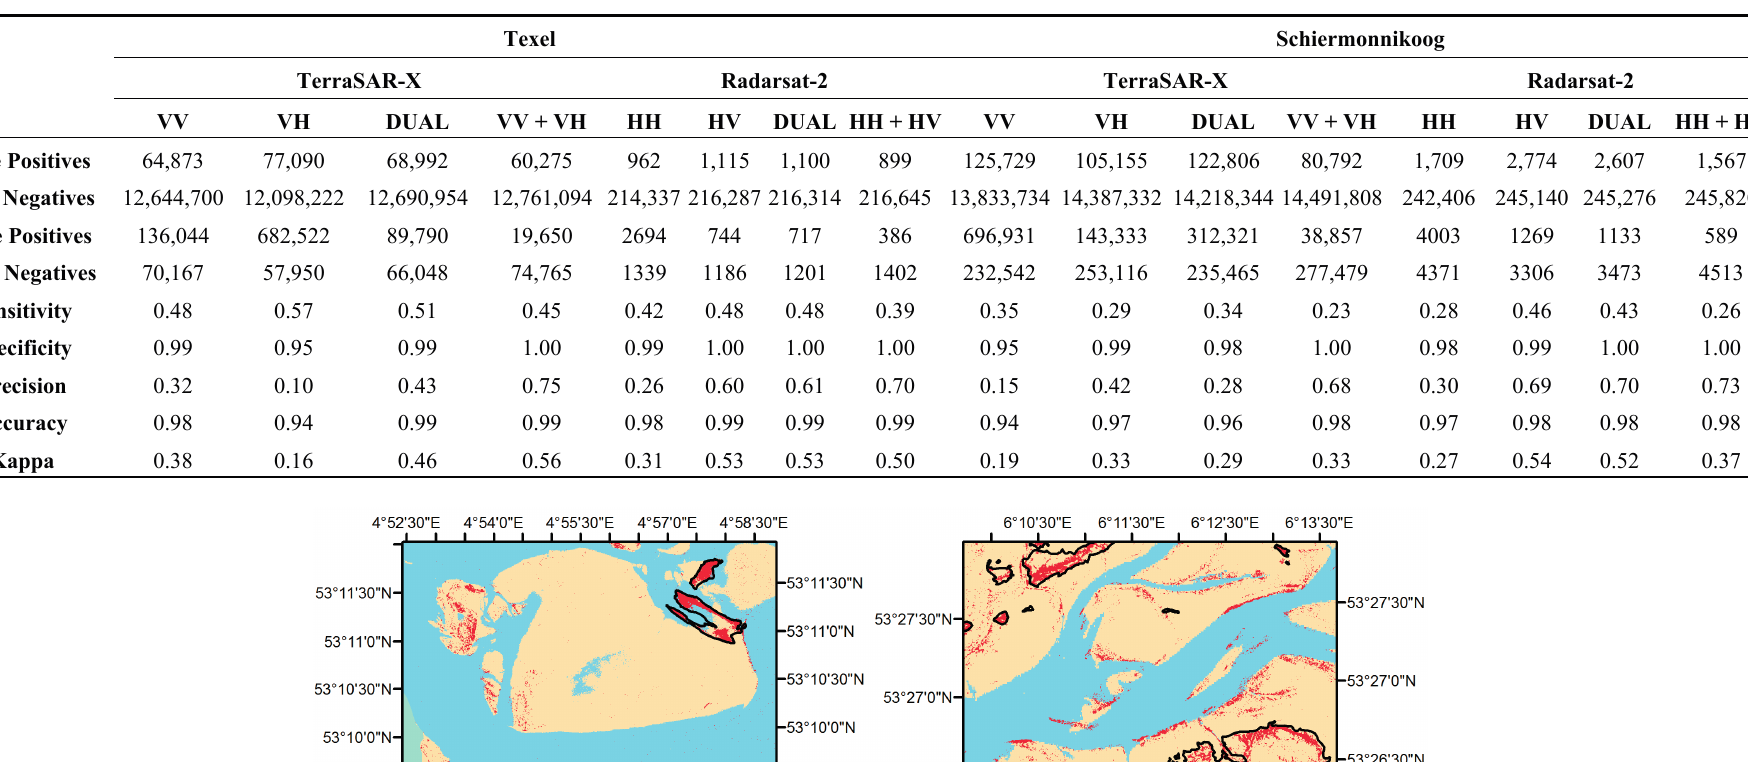
Table 5. Agreement between the SAR shellfish classification and the TMAP monitoring survey for the two sensors at Texel and Schiermonnikoog (see the text and Table 3 for an